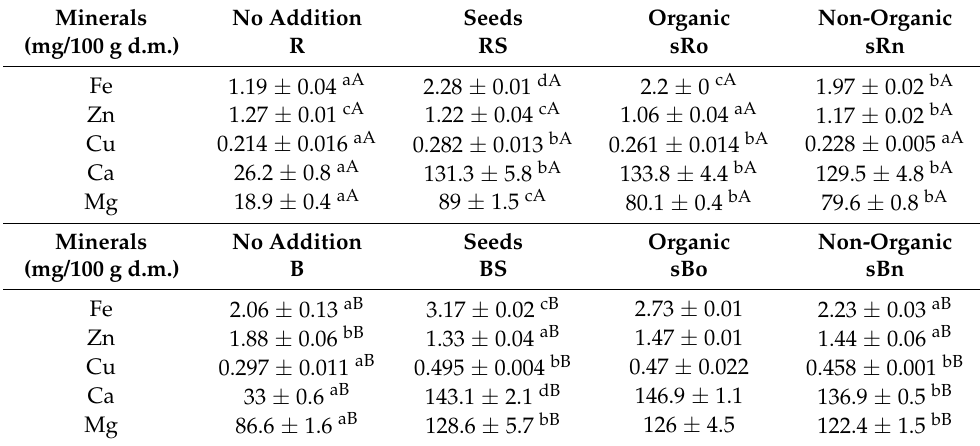
Table 1. Content of selected minerals in breads.